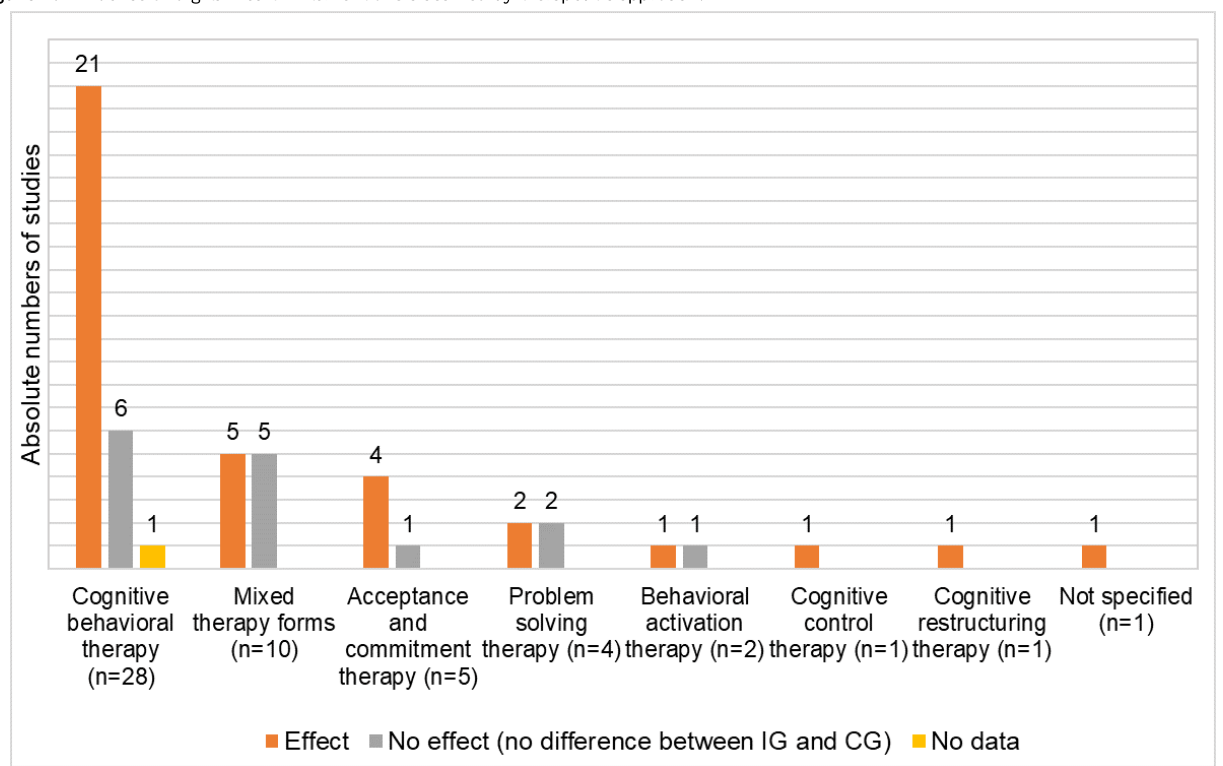
Figure 4. Evidence of digital health interventions classified by therapeutic